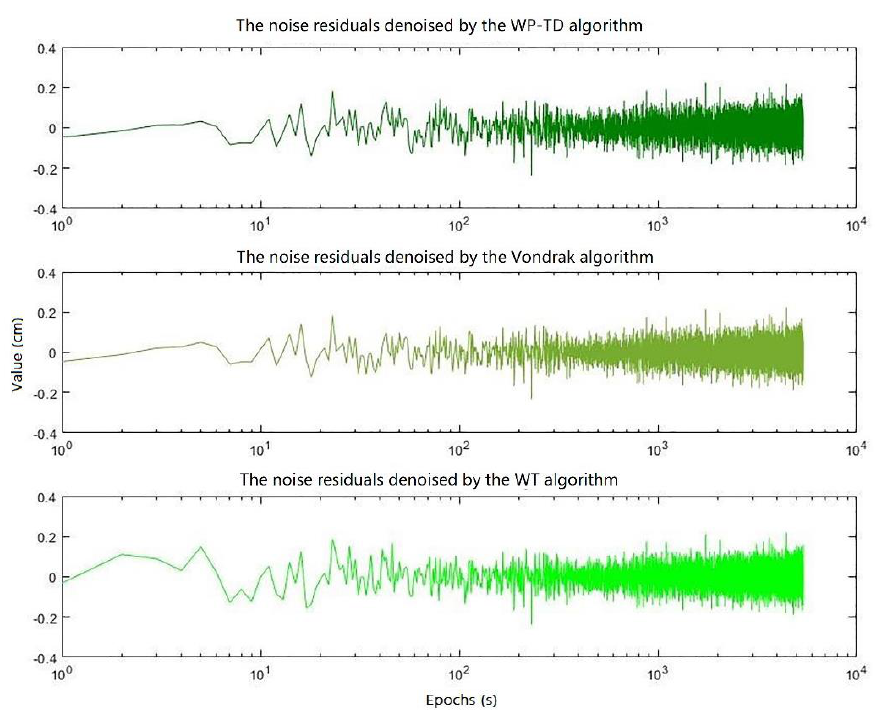
Figure 12. Noise residuals denoised by the three algorithms on the first day.